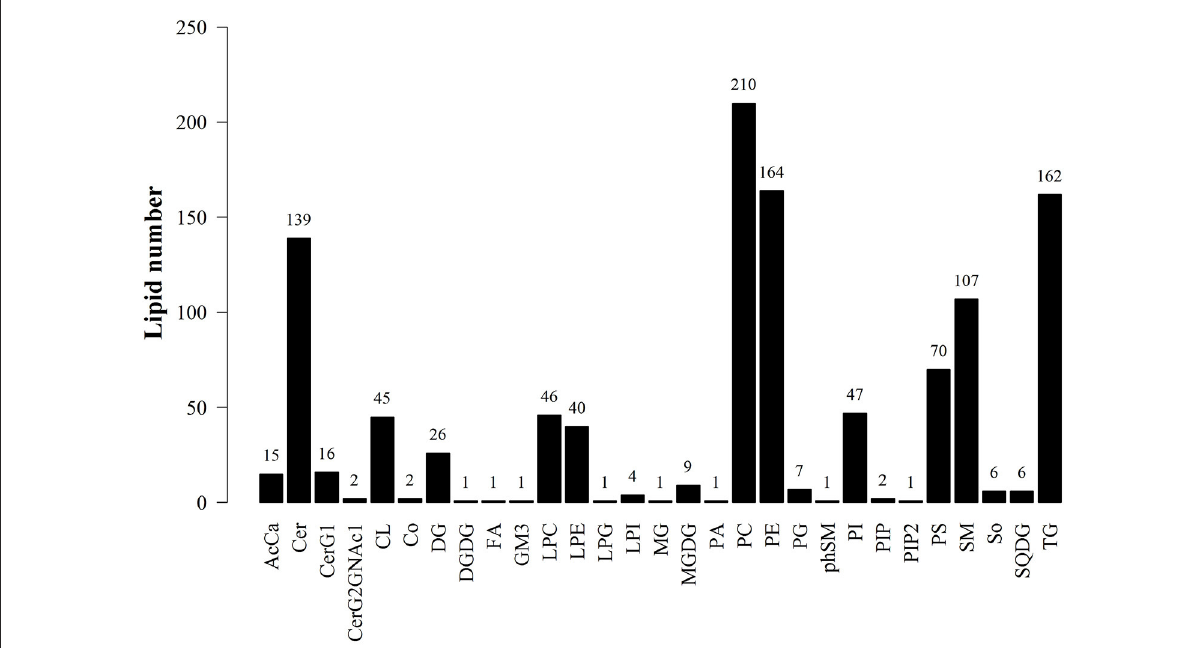
FIGURE3 Statistics of lipid subclasses and lipid molecules. AcCa (Acyl Carnitine), Cer (ceramides), CerG1 (glucocerebroside), CerG2GNAc1 (Simple Glc series), CL (cardiolipins), Co (Coenzyme), DG (Triacylglycerol), DGDG (digalacyosyl diacylglycerols), EPA (Eicosapentaenoic acid), FA (fatty acid), GM3 (Gangliosides), LPC (lyso-Phosphatidylcholine), LPE (lyso-Phosphatidylethanolamine), LPG(lyso-phosphatidylglycerols), LPI (lyso-phosphatidylethanola), MG (monoacylglycerol), MGDG (monogalactosyldiacylglycerols), PA (phosphatidic acids), PE (phosphatidylethanola mines), PG (phosphatidylglycerols), PhSM (phytosphingosine), PI (phosphatidylethanola), PIP (phosphatidylinositol (4)phosphate), PIP2 (phosphatidylinositol (4,5)bisphosphate), PS (phosphatidylserines), SM (sphingomyelin), So (Sphingosine), SQDG (Sulfoquinovosyldiacylglycerol), TG